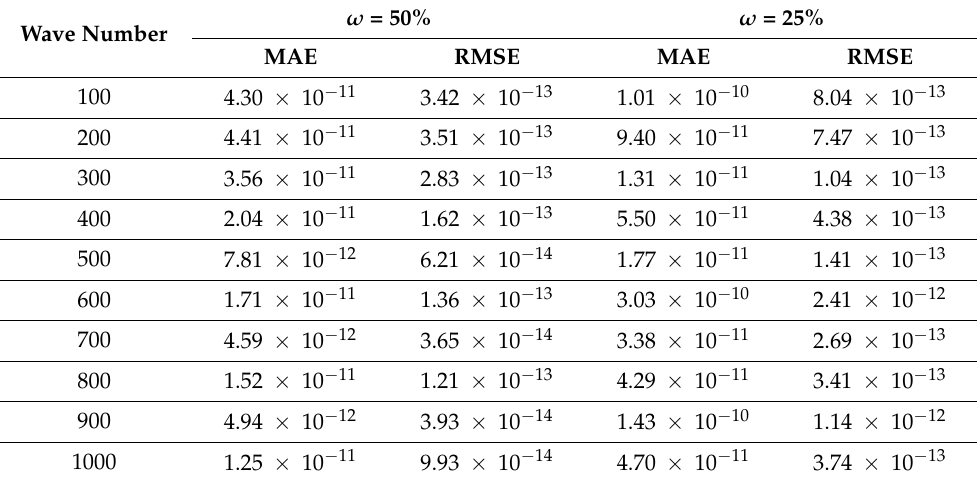
Figure 11. Comparison of solution along the hole boundary with δ = 0.03.